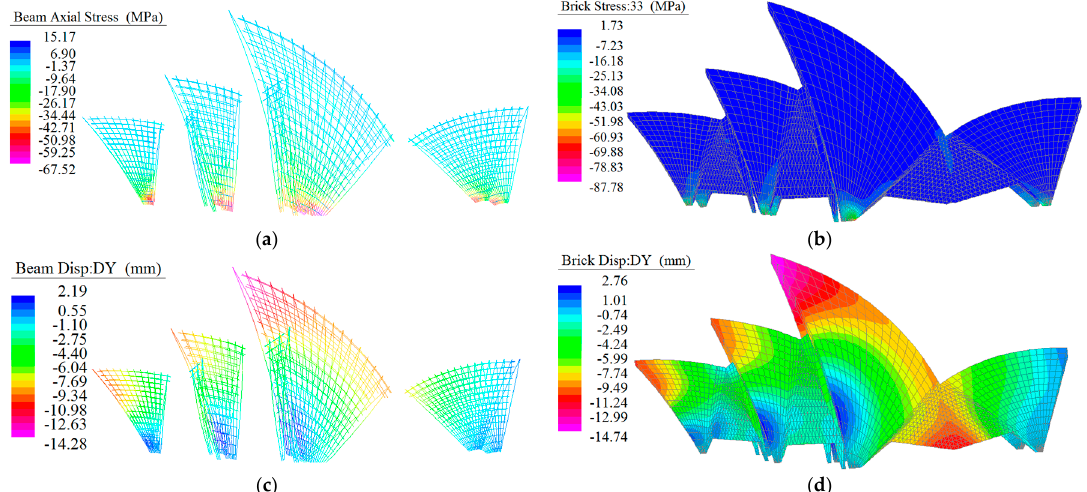
Figure 2. Strand7 dead load outputs (unscaled) ( a ) cable stress, ( b ) concrete stress, ( c ) cable displacement, ( d ) concrete displacement .